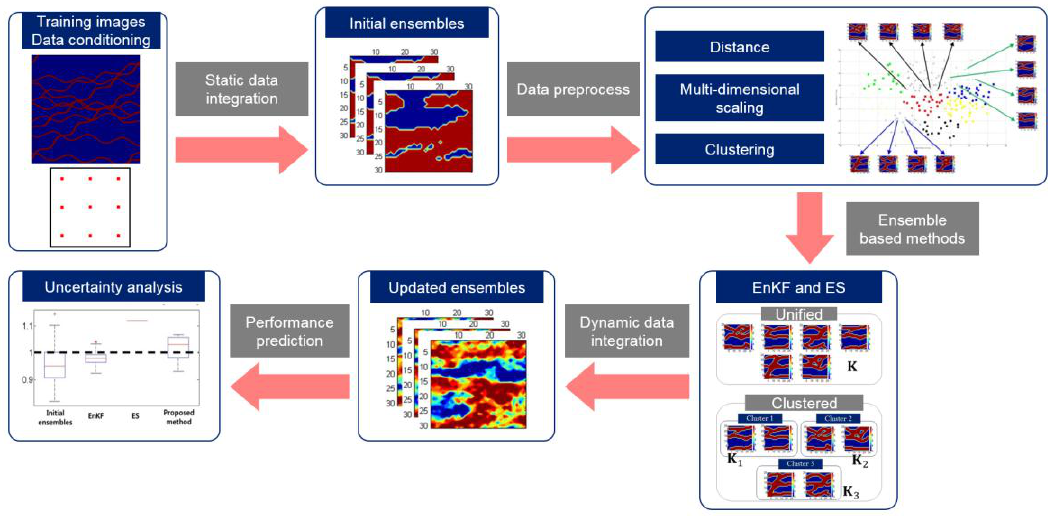
Figure 9. Typical workflow to forecast production performances integrating data clustering with ensemble-based methods at channelized reservoirs [65].